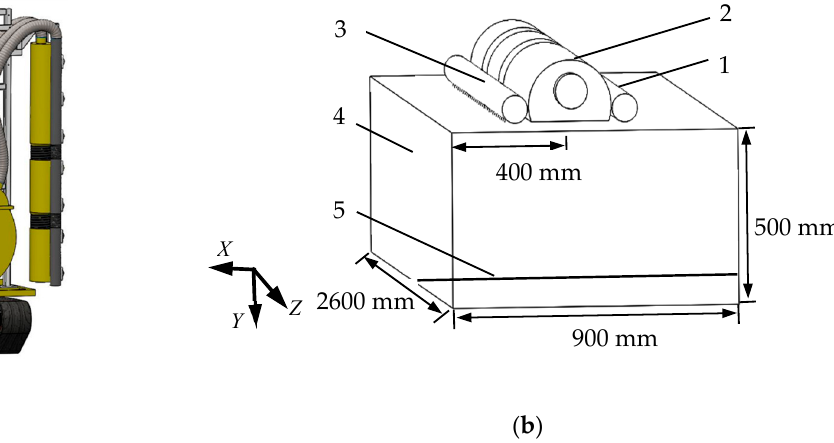
Figure 4. Calculation model structure diagram. Schematic diagram of the spray flow model ( a ). Top view of the spray flow field model ( b ): 1. Anti-drift airflow duct; 2. Spray airflow duct; 3. Turbulent airflow duct; 4. Crosswind; 5. Droplet concentration calibration line (paralleling the X-axis direction and coinciding with the origin of the model coordinates).